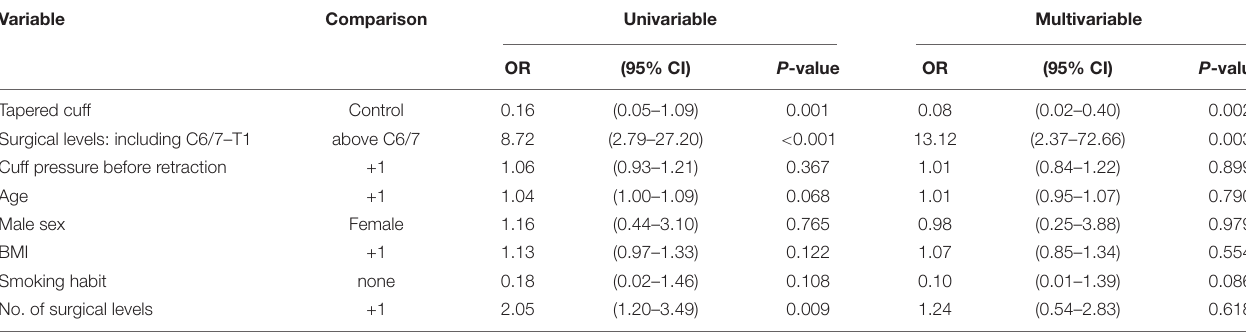
TABLE 2 | Factors associated with maximal cuff pressure > 25 mmHg after the retractors